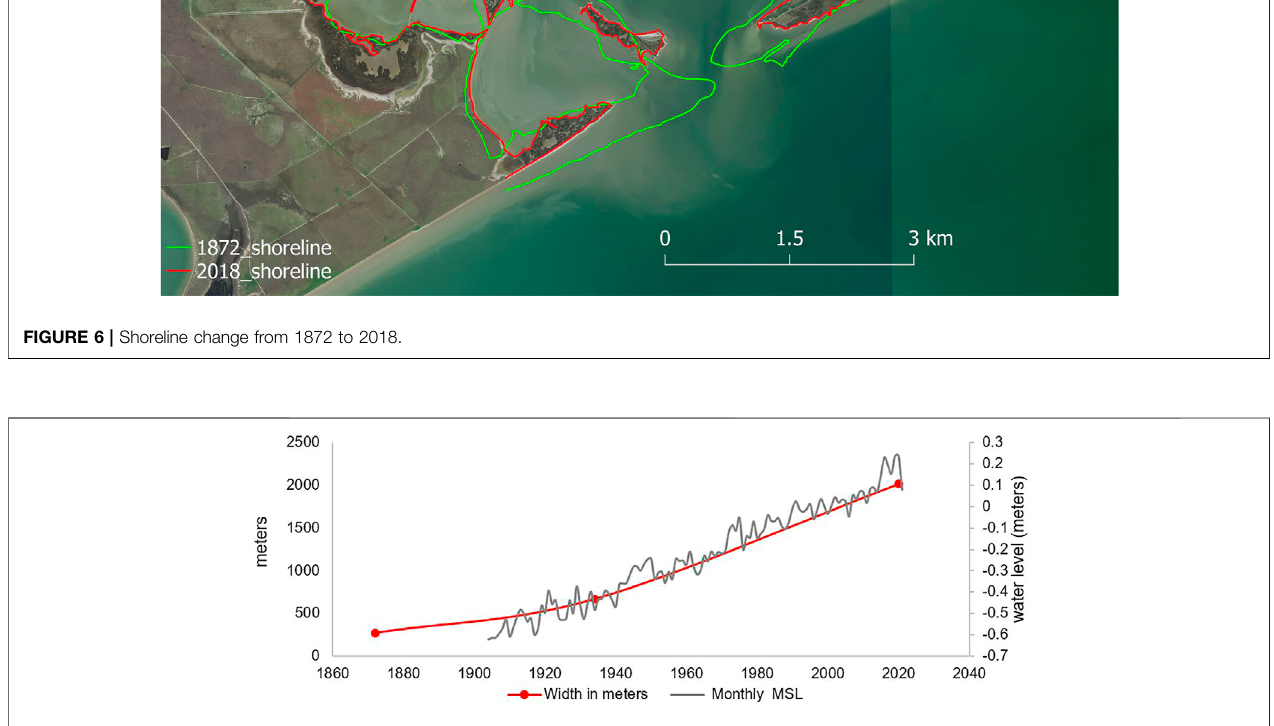
FIGURE 7 | The width of the Carancahua Bay inlet and relative water level change over time.